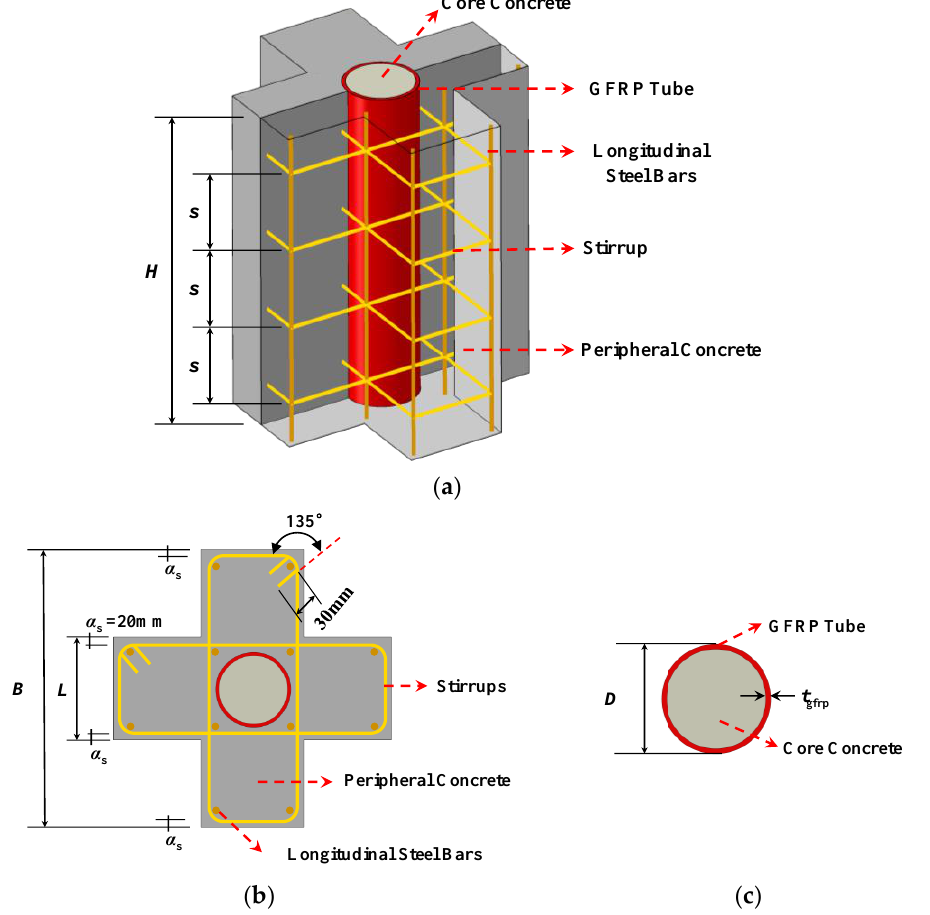
Figure 1. The schematic diagrams of the EGCSSC: ( a ) the composition of EGCSSC; ( b ) the cross- section of EGCSSC; ( c ) the cross-section of the GFRP core column. Table 1. Specific parameters of 27 EGCSSCs.